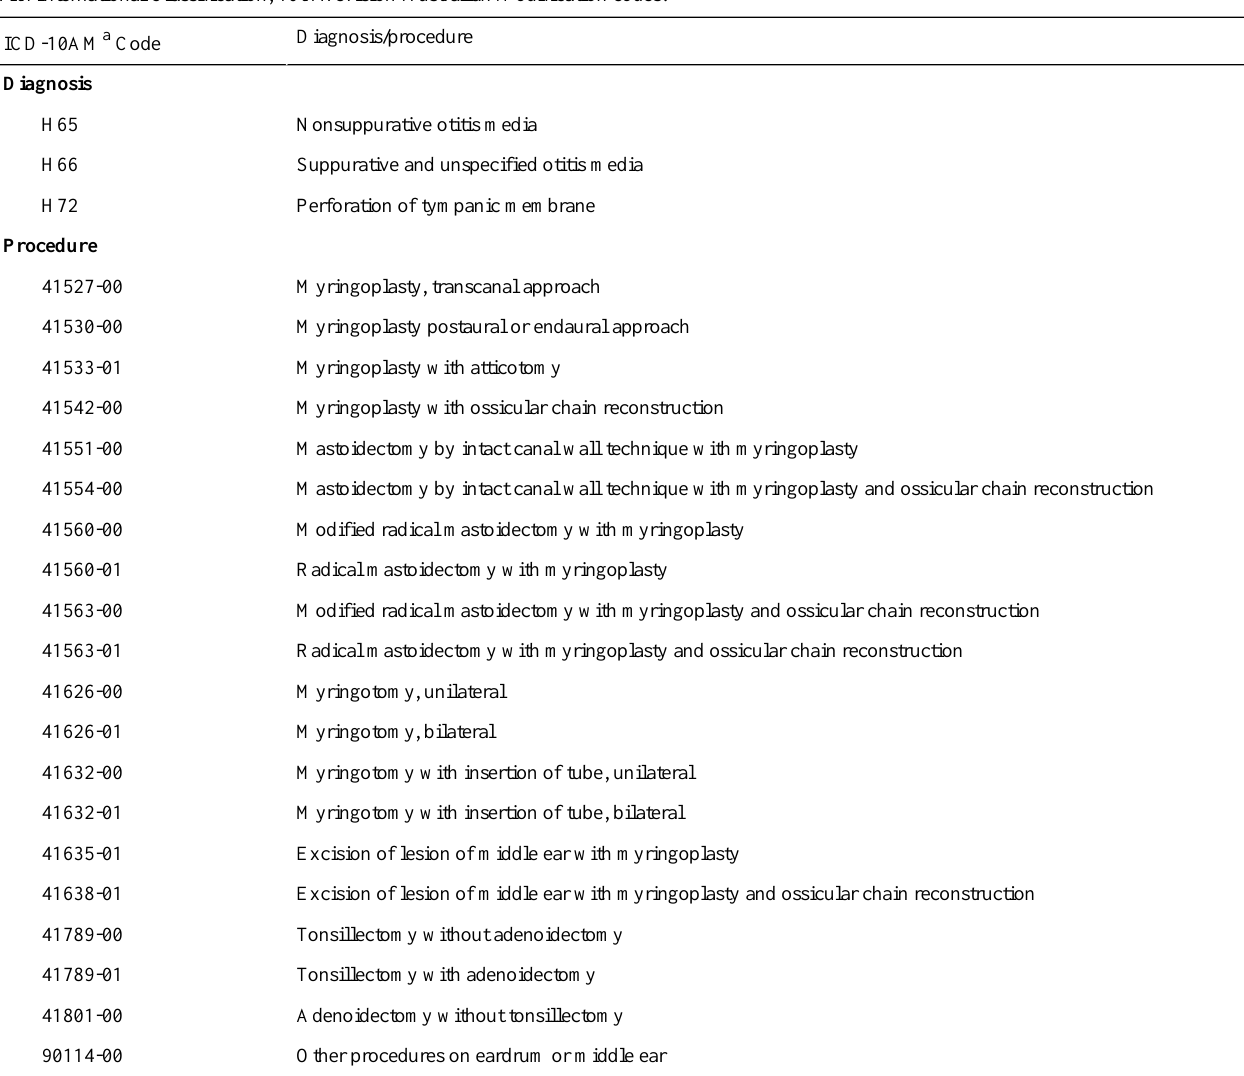
Table 1. Otitis media—related hospital admission diagnoses and surgical procedures used to exclude children who had received surgical treatment, with International Classification, 10th Revision-Australian Modification